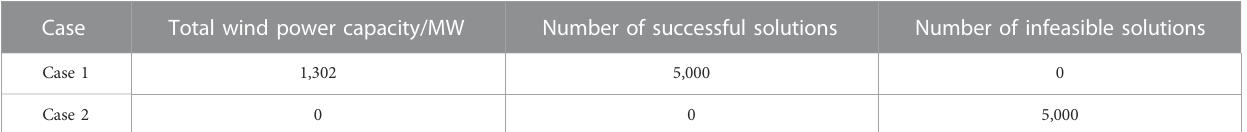
TABLE 8 Monte Carlo simulation results.